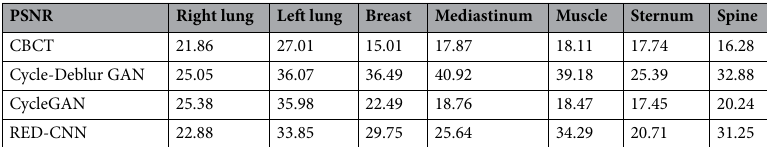
Table 3. PSNR comparison of different models at different